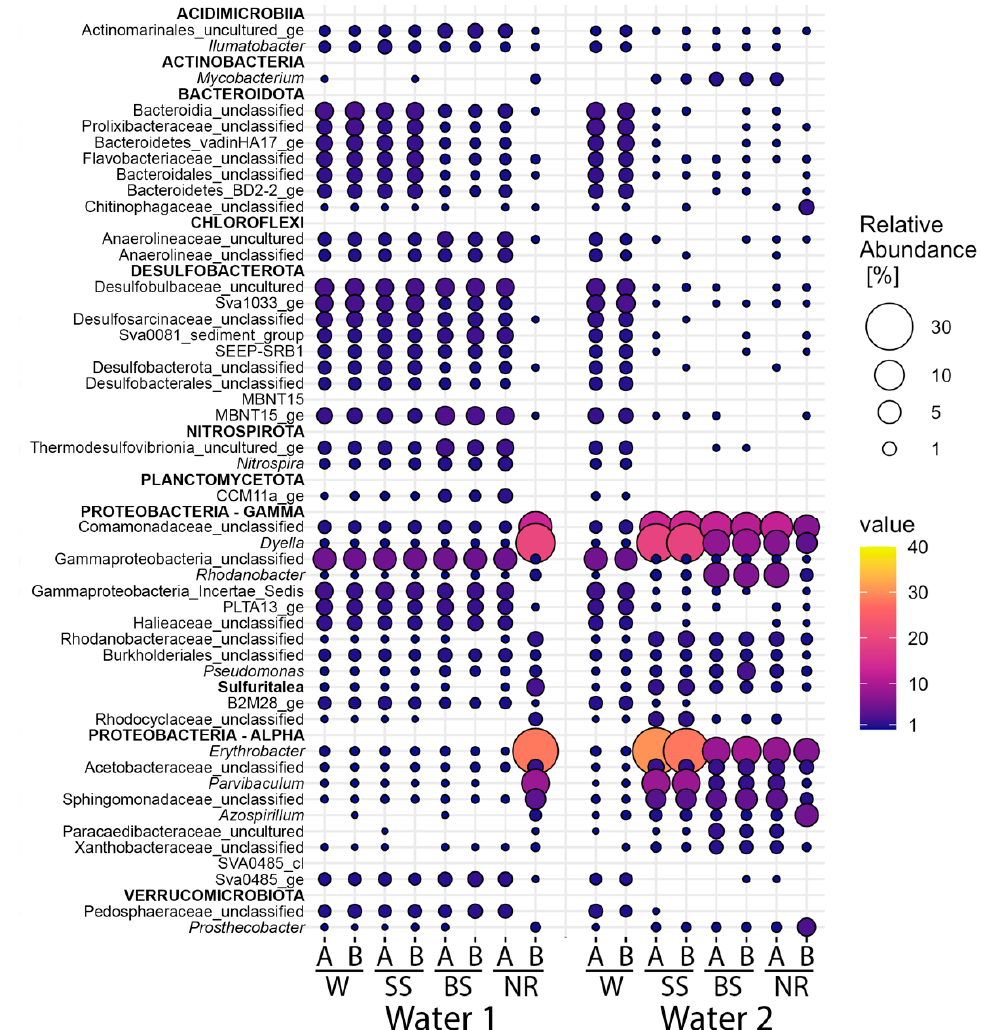
Figure 4. The relative abundance of the most common bacterial genera in the mine waters and microcosm water samples at the end of incubation. The colour scale and size of the dots indicate the relative abundance of each identified genus in each sample, according to the rulers on the right of the graph. The relative abundances of unclassified bacteria and the combined relative amounts of minor genera that each contributed with less than 1% of the bacterial communities in all samples are presented in Table 4. W, SS, BS and NR indicate original mine water (W), microcosms containing sandstone (SS), black shale (BS) and no rock (NR), respectively, and A and B indicate replicate microcosms.